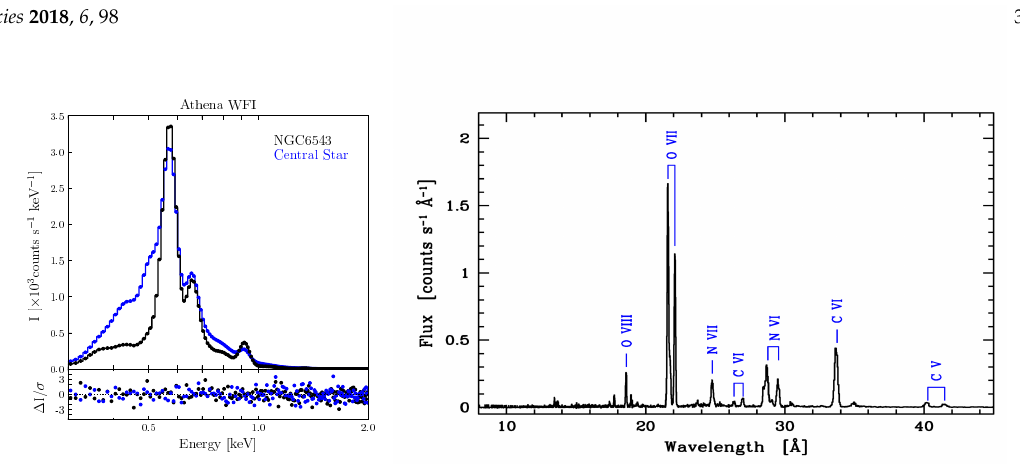
Figure 1. ( left ) Simulated ATHENA (Advanced Telescope for High-Energy Astrophysics) Wide Field Imager (WFI) 10 ks spectrum of NGC6543 modeled using nebular (black) or stellar (blue) abundances. ( right ) Simulated ATHENA X-ray Integral Field Unit (XIFU) 20 ks spectrum of